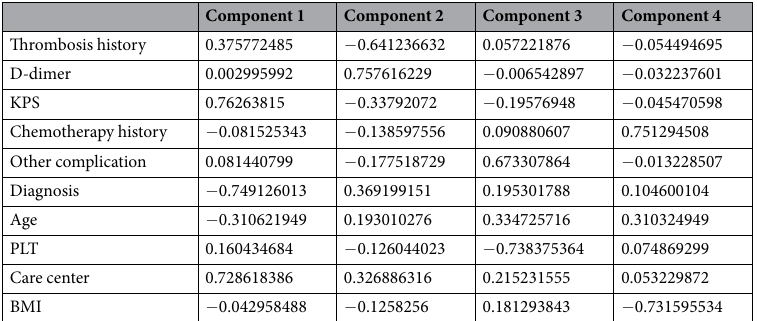
Table 3. The feature vector relative rotation